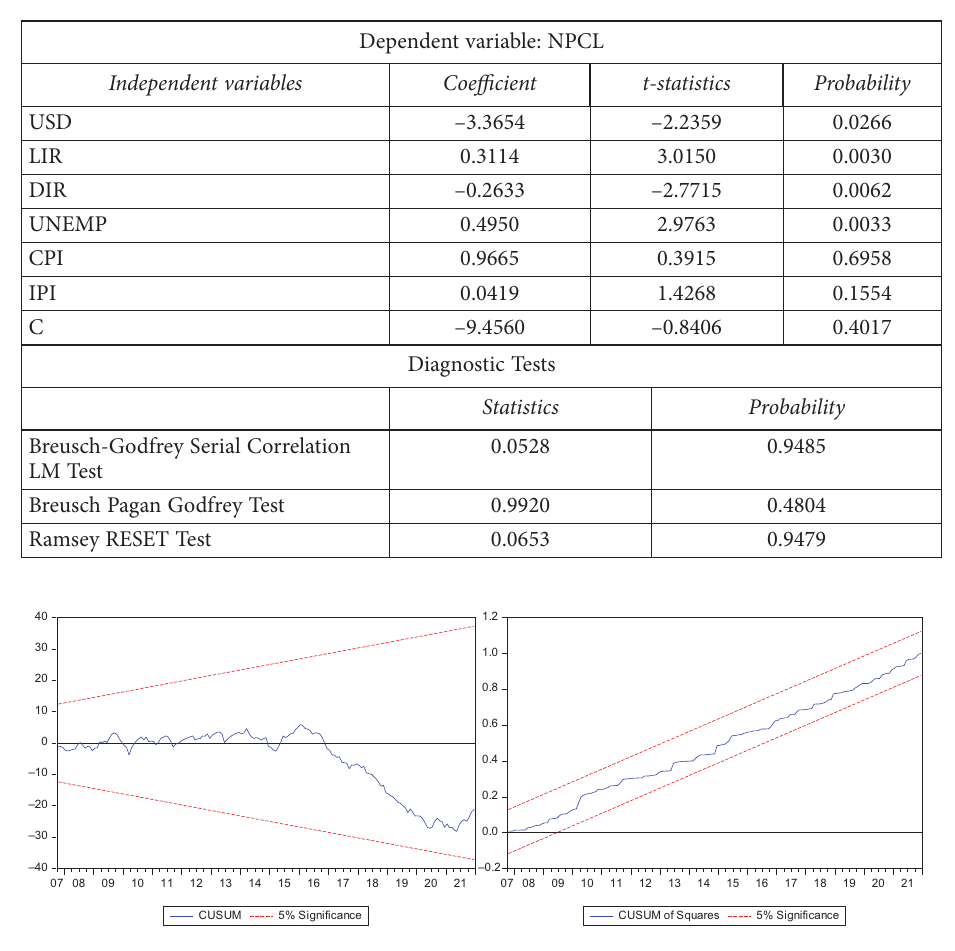
Figure 2. CUSUM and CUSUMSQ Test Results (source: own calculation of